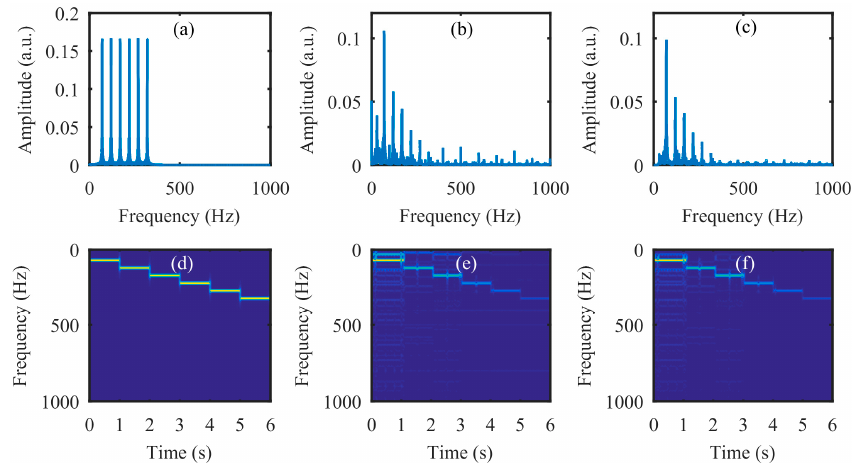
Figure 13. The experimental results for an audio signal consisting of six sinusoidal sound segments with increasing frequencies from 70 Hz to 320 Hz with an interval of 50 Hz. Each segment lasted one second. ( a ) The test sound frequency spectrum; ( b ) the recovered sound frequency spectrum without filtering and ( c ) with filtering; ( d ) the test audio spectrogram; ( e ) the recovered audio spectrogram without filtering and ( f ) with filtering.